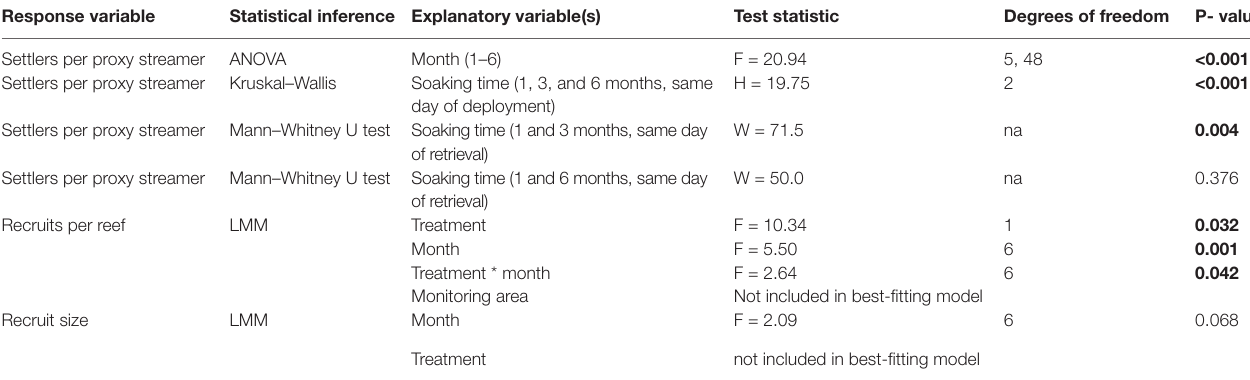
TABLE 3 | Statistical inference, explanatory variables, test statistics, degrees of freedom, and P-values per response variable.